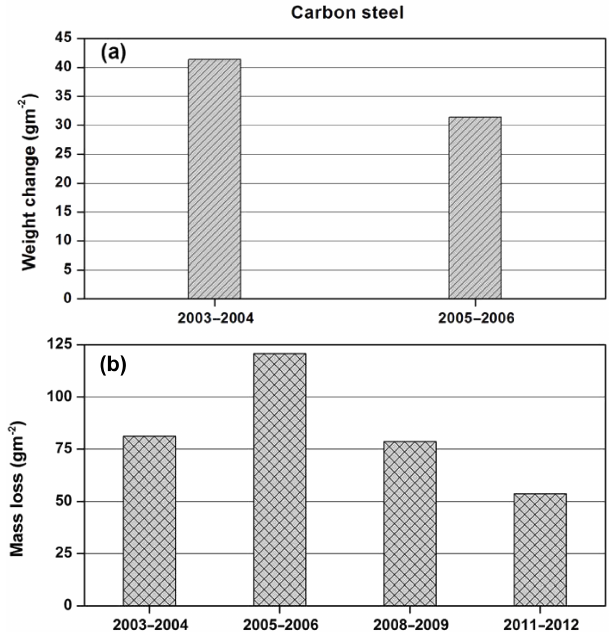
Figure 4. (a) Mean weight change of carbon steel samples exposed